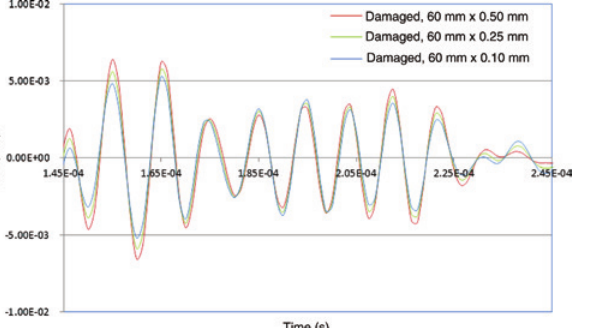
Figure 17: Zoomed-in region of wave responses.